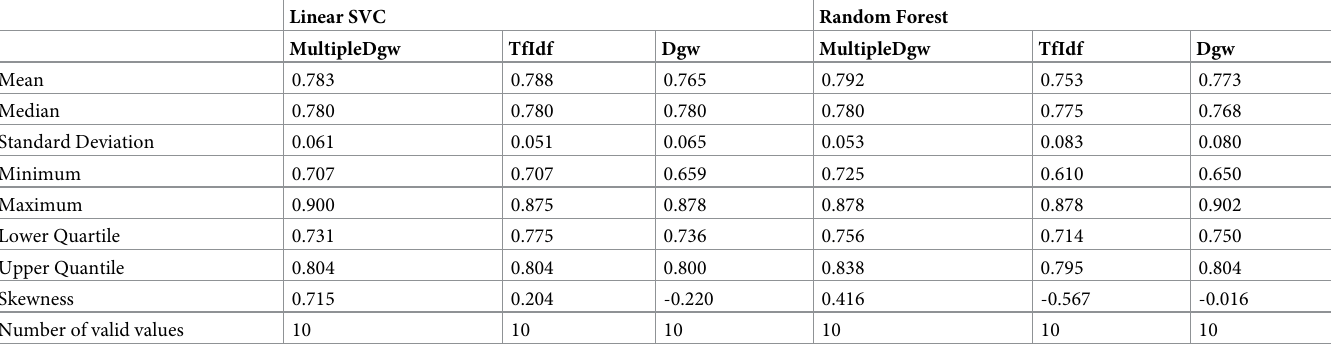
Table 5. Descriptive statistics for accuracy results for the KaiDMML